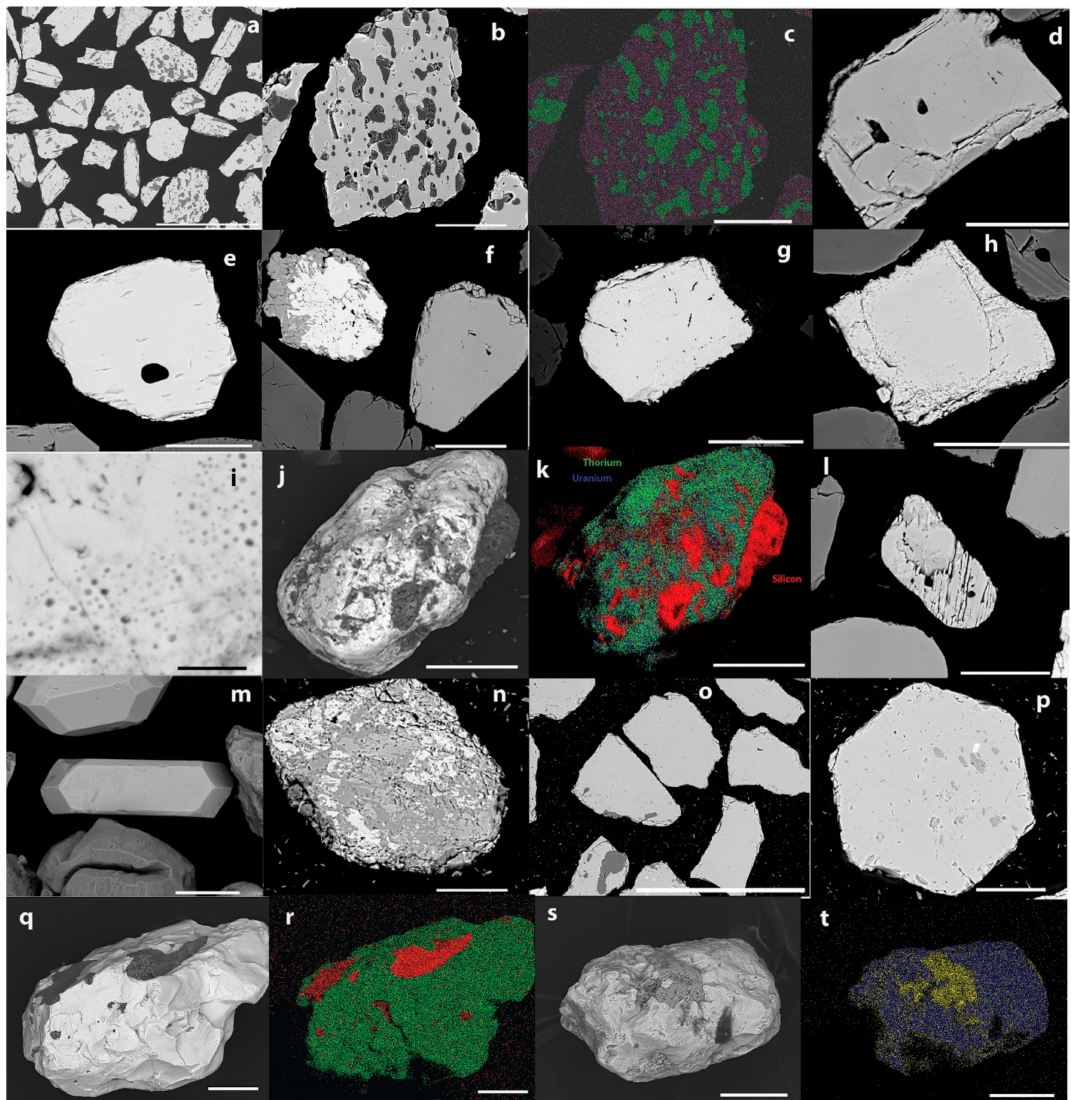
Figure 12. SEM backscatter and elemental maps of a range of mineral grains in polished section or whole grains. ( a ) A selection of ilmenite grains; ( b , c ) ilmenite with inclusions of apatite and silicates, Si (green), P (blue), and Ti (purple); ( d , e ) monazite; ( f ) titanite (upper left) and allanite (right); ( g , h , i ) thorite showing areas of radiation damage; ( j , k ) thorite with inclusions of silicate, Th (green) U (blue), Si (red); ( l ) scheelite; ( m ) zircon; ( n ) a mixed titanium rock fragment, titanite (dark gray), rutile (light gray), ilmenite (white); ( o ) garnet with inclusions of quartz and ilmenite; ( p ) garnet with an inclusion of zircon, and inclusions without Fe and Mn; ( q , r ) cassiterite with silicate inclusion; ( s , t ) columbite, with magnetite inclusion, Nb (blue), Fe (yellow); Scale bar: ( a ), ( o ) = 300 µ m; ( i ) = 2 µ m; others = 50 µ